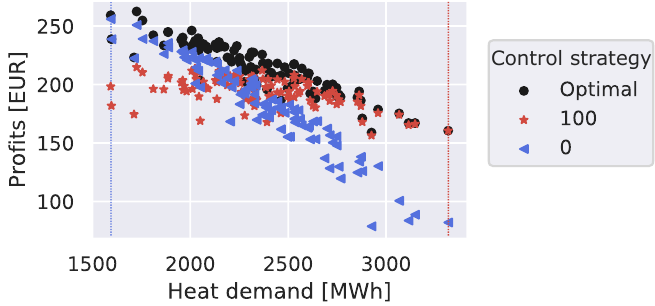
Figure 8. On the x -axis the heat demand during the Winter_Negp e day is shown, on the y -axis the profit that was obtained. Every dot represents one version of GenkNET managed by one control strategy, the colour and marker shape indicate the applied control strategy. One version will always have the same heat demand, regardless of the applied control strategy. The vertical dotted lines show the heat demand that corresponds to the 0 and 100 control